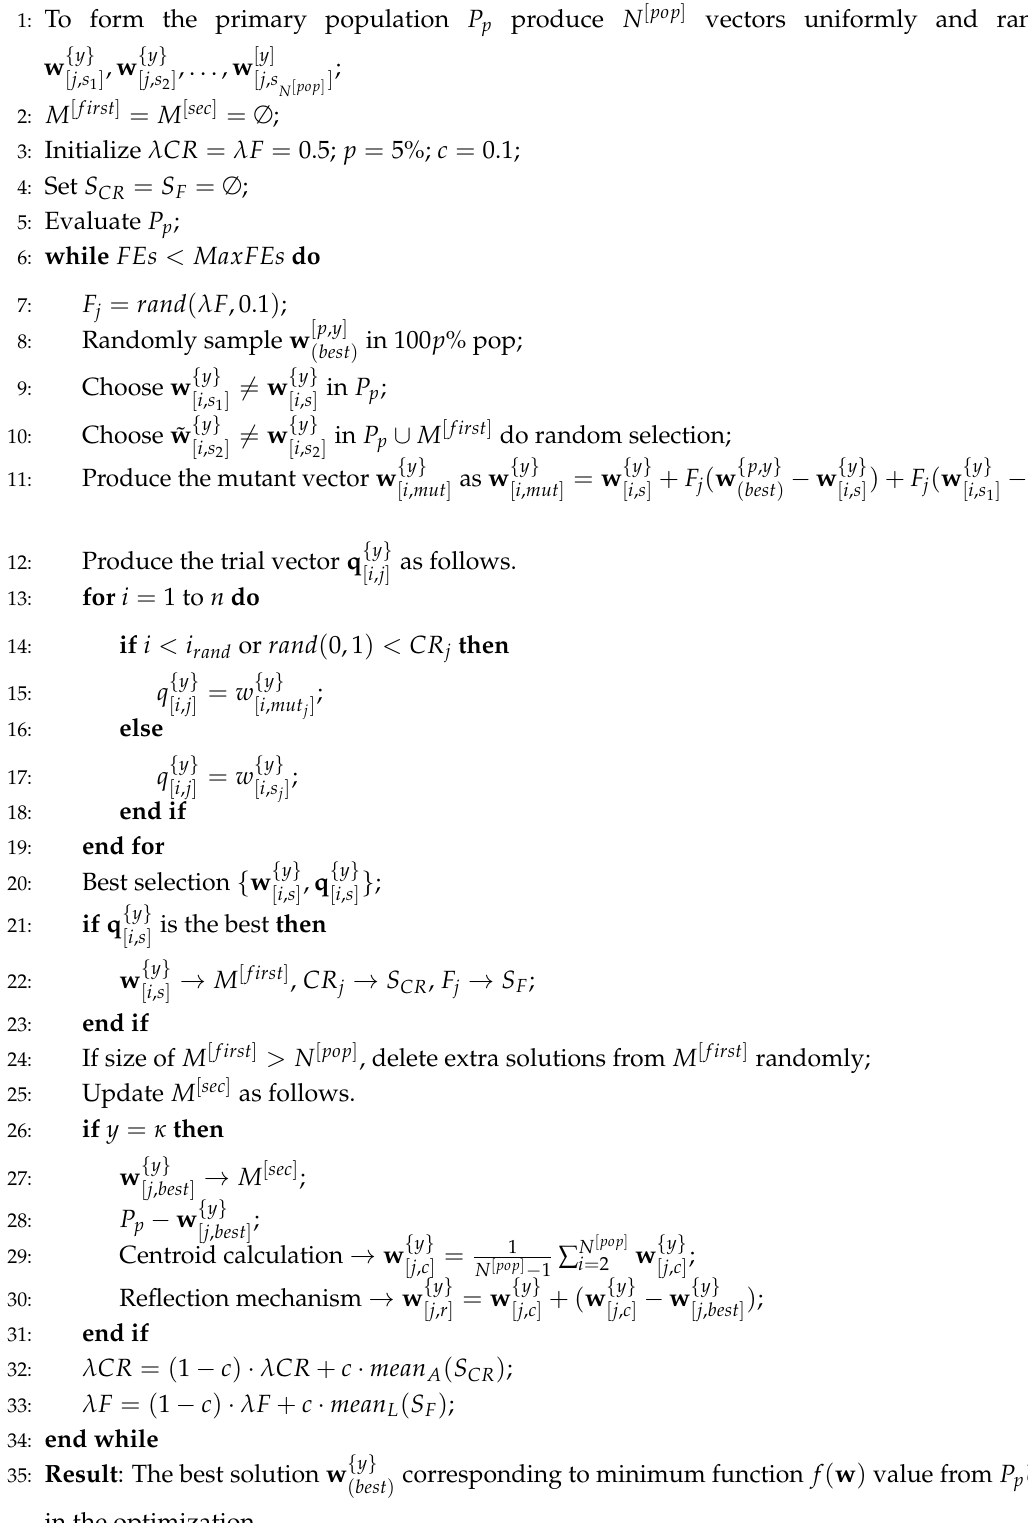
Algorithm 1 Outlines of RJADE/TA